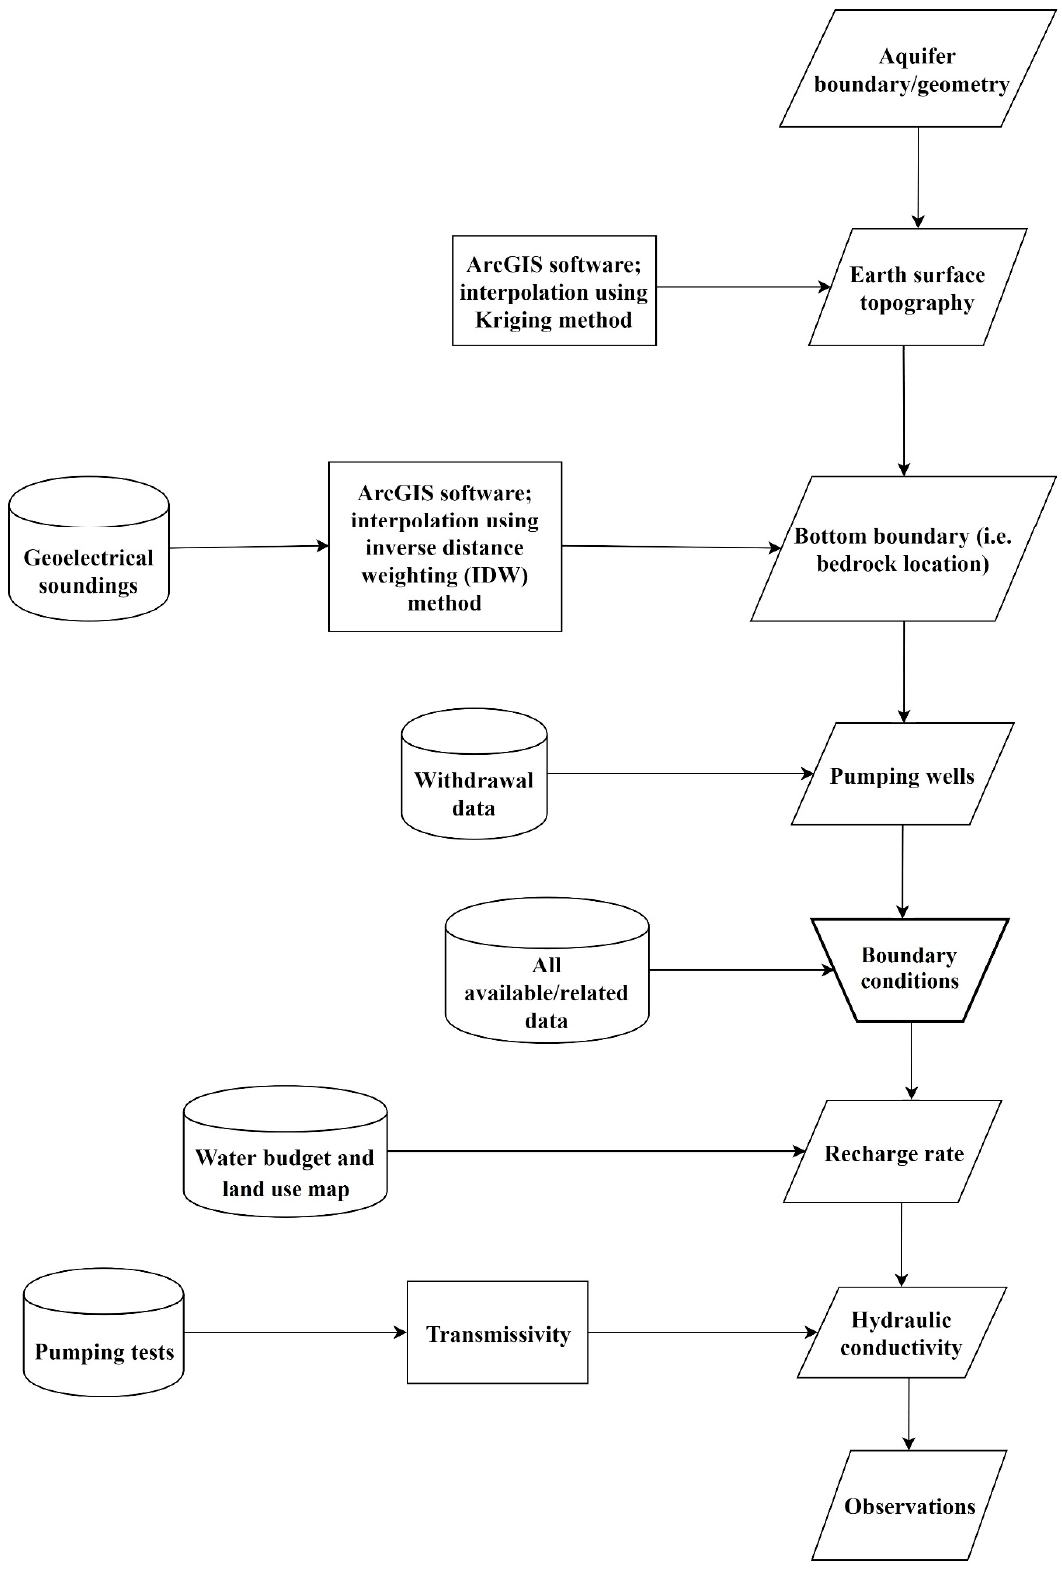
Figure 7. Flowchart of the building the conceptual model of Birjand aquifer.